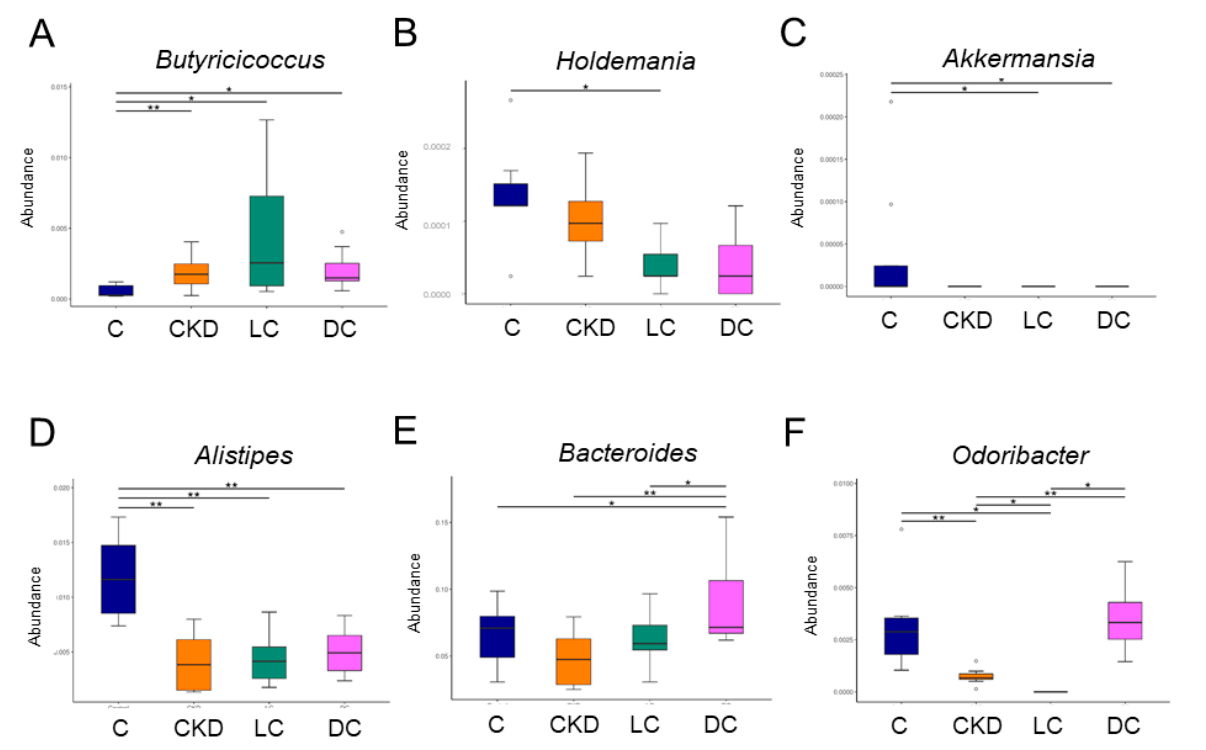
Figure 6. Effect of maternal chronic kidney disease (CKD), L -cysteine (LC), and D -cysteine (DC) on the gut microbiome at the genus level. Relative abundance of the genera ( A ) Butyricicoccus , ( B ) Holdemania , ( C ) Akkermansia , ( D ) Alistipes , ( E ) Bacteroides , and ( F ) Odoribacter . n = 8/group. * p < 0.05; ** p < 0.01.